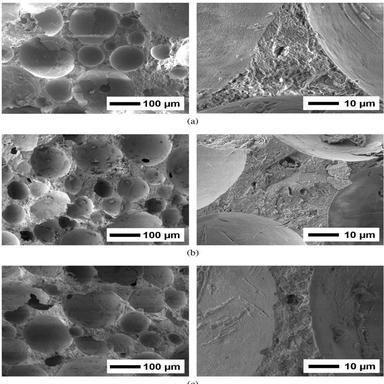
SEM images of the pore and solid structures of foamed concrete (FC) specimens: (a) FC500, (b) FC750, (c) FC1000.